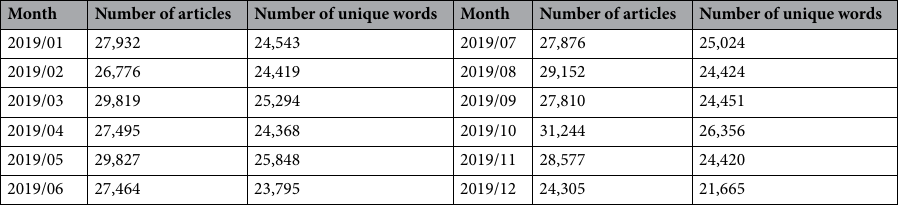
Table 5. Number of articles and unique words in 2019.